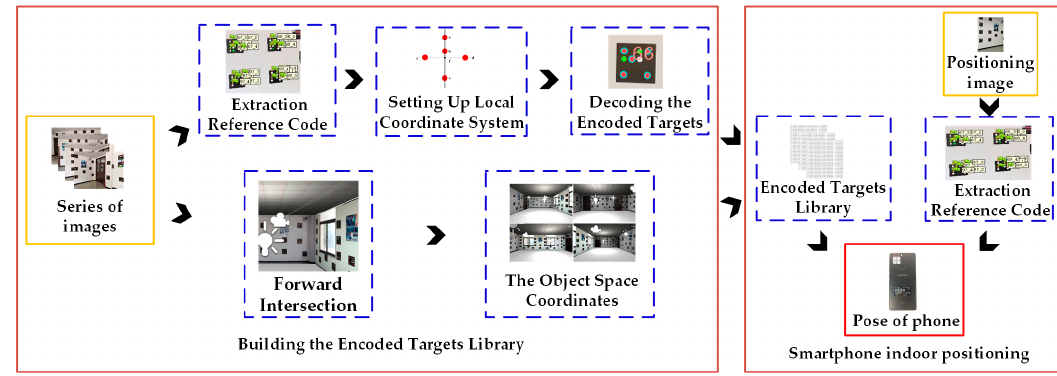
Figure 4. Workflow of smartphone indoor positioning using visual encoded targets.